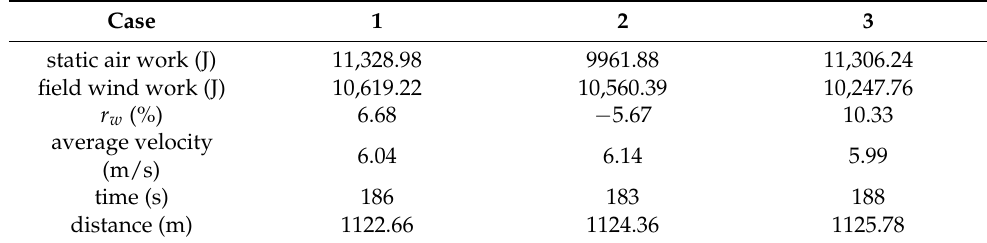
Table 2. Three training results for the